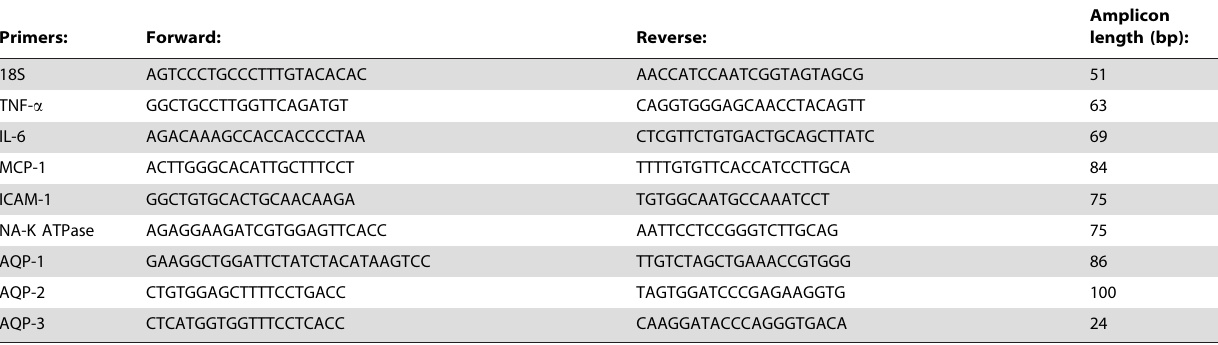
Table 1. qRT-PCR primers.